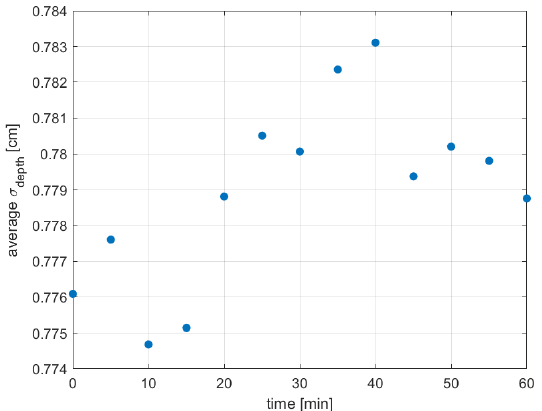
Figure 4. Values of the average σ depth separately evaluated on different time sequences collected during a one-hour acquisition.